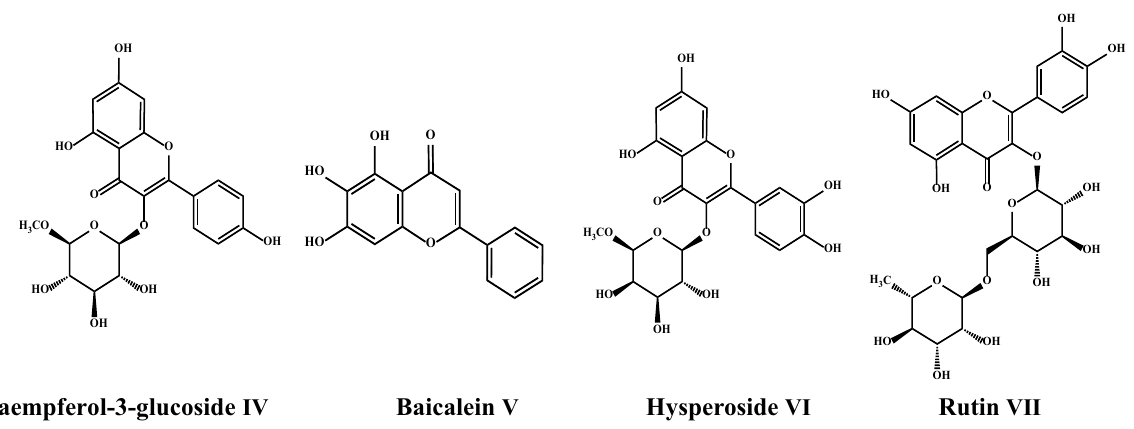
Figure 9. Structures of the extracted flavonoid compounds. Energy level